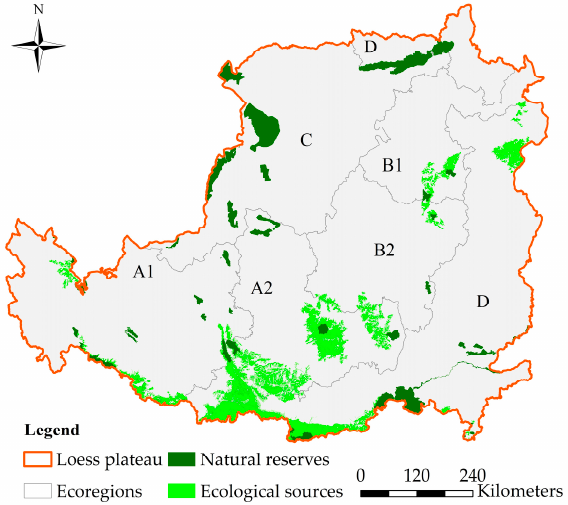
Figure 5. Spatial distribution of ecological sources on the Loess Plateau.